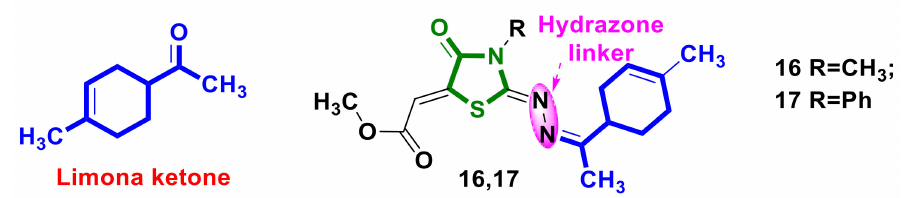
Figure 7. Structures of 4-thiazolidinone hybrids with limona ketone.